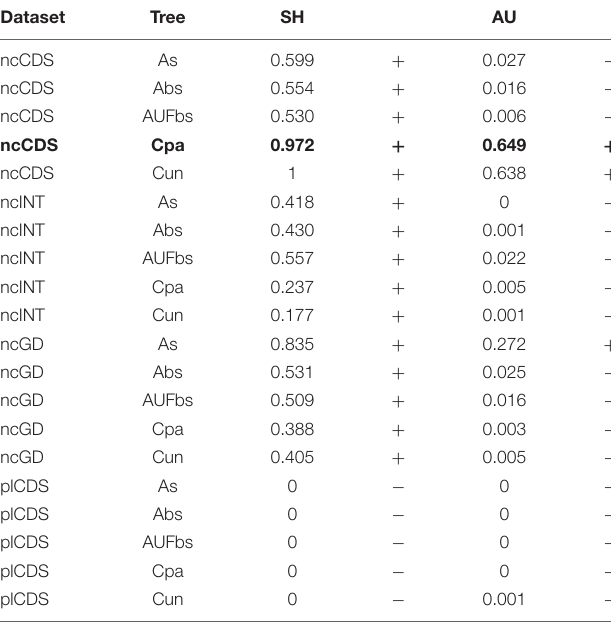
TABLE 3 | Tree topology test contrasting a fixed tree in bold (concatenated partitioned reconstruction based on ncCDS) with all species trees in which p -value < 0.05 is rejected ( − ) as similar to the fixed tree, while p -value > 0.05 is accepted ( + ) as having a similar topology with the fixed tree.